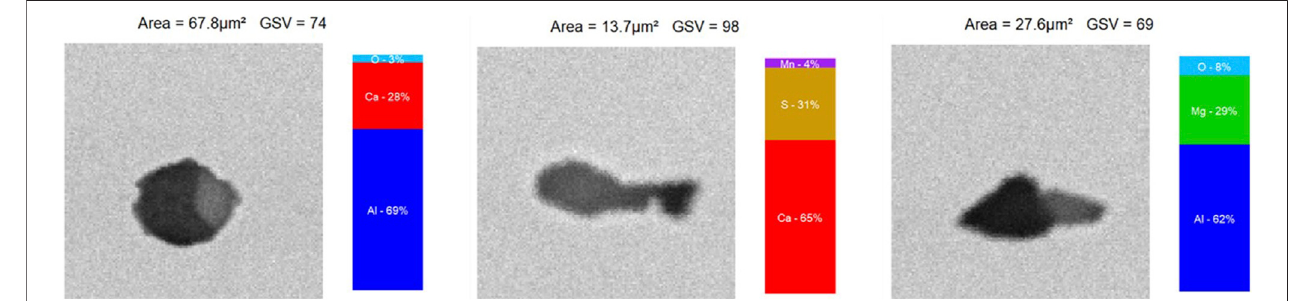
FIGURE 8 | Example of multiphase inclusions, with EDS measurement (composition bar) detecting only one phase.